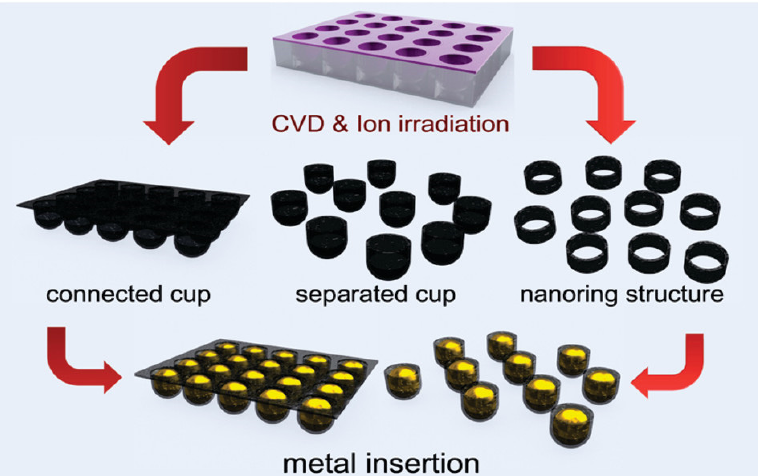
Figure 25. Fabrication approach to fabricate architectures of a connected arrays of nano-cup film, individually, separated nano-cups, nano-rings, and nano-containers for metal nanoparticles. Reprinted with permission from Ref. [225]. Copyright © 2023, the American Chemical Society.